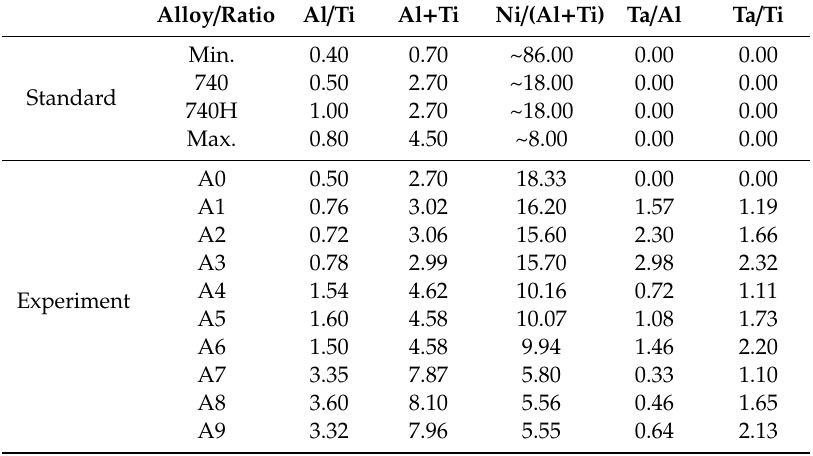
Table 4. Ratios of alloying elements in Inconel 740, Inconel 740H and modified